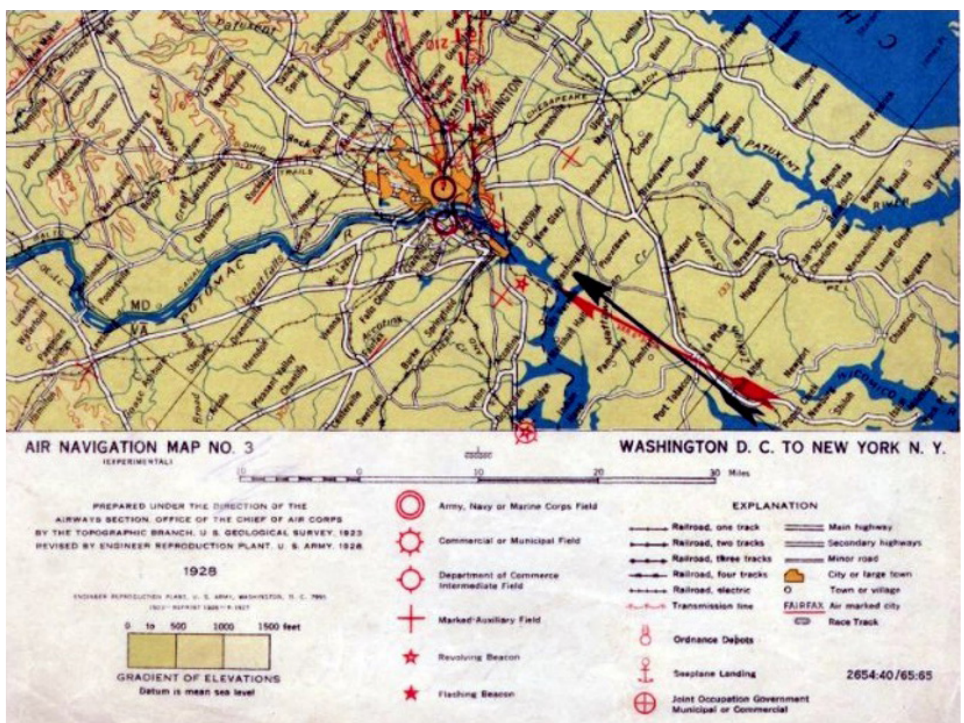
Fig. 1. An example of an American strip aeronautical chart at the scale of 1:500,000 from 1928, depicting the air route between Washington and New